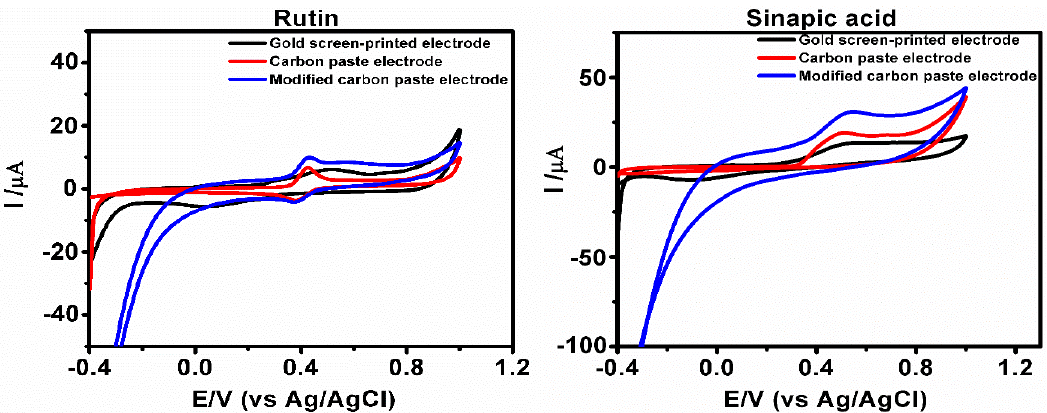
Figure 8. Cyclic voltammograms show an overlay of the gold screen-printed electrode with CPE and MCPE of the phenolic compounds rutin and sinapic acids in 0.5 M ABS of pH 4.8 at a scan rate of 0.2 V/s with a reversible scanning potential range of −0.4 to 1.0 V.